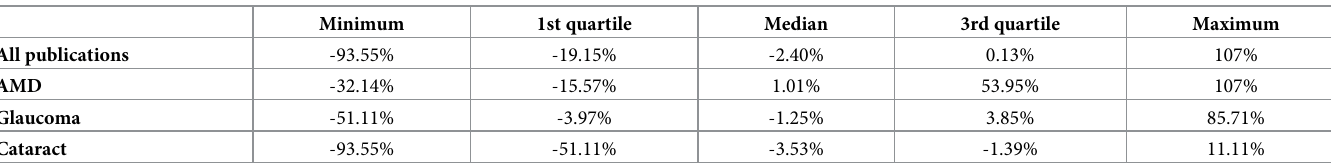
Table 8. Distribution of deviations.